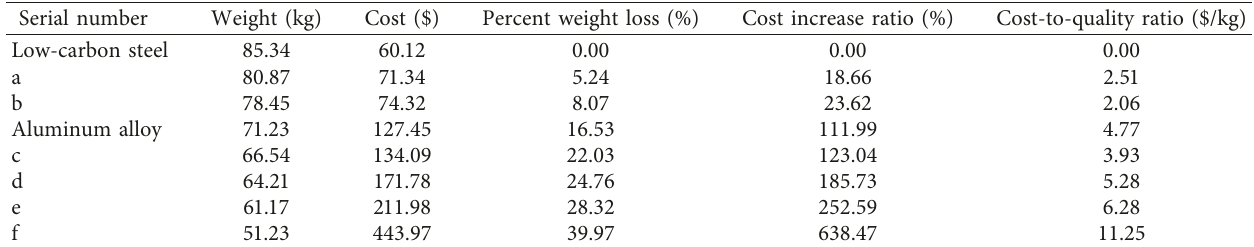
Table 5: Optimization results of lightweight design combination of multi-material structure